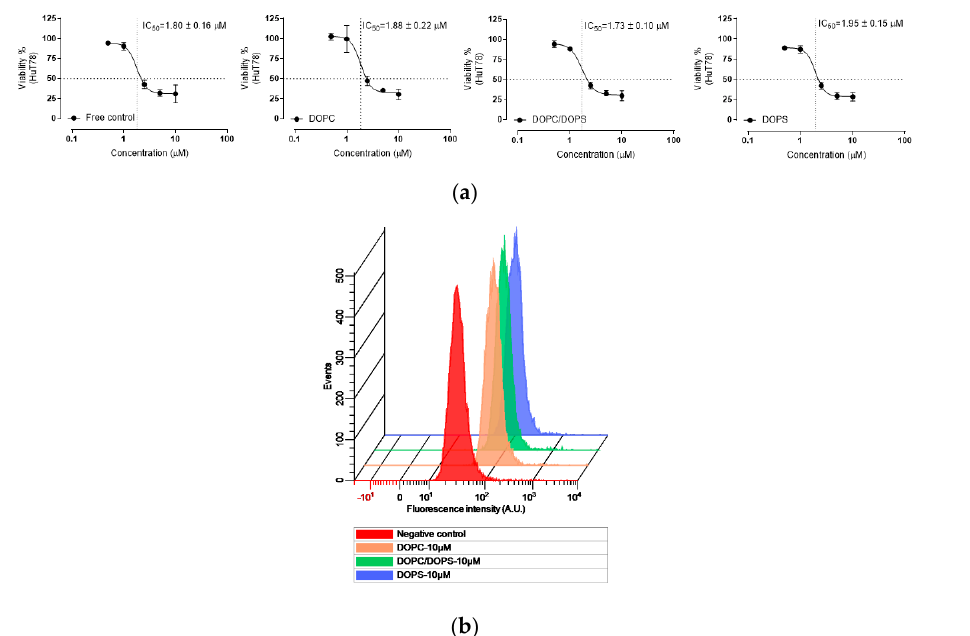
6 of 17 Figure 4. Fourier-transform infrared (FTIR) spectrum of belinostat free drug, empty liposomal formulations and belinostat-loaded liposomal formulations. 2.4. In Vitro Cytotoxicity and Cellular Uptake Study The cytotoxicity and IC 50 value of belinostat free drug and belinostat-loaded liposomal formulations on HuT-78 cell lines are shown in Figure 5a. The results showed that belinostat free